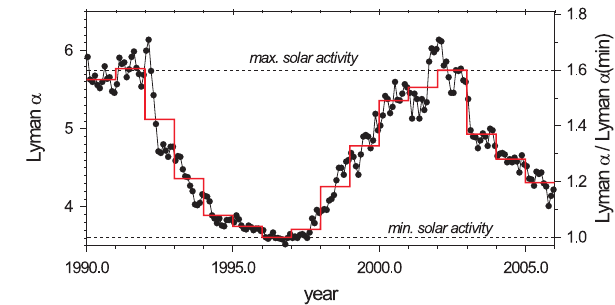
Fig. 2. Variation of the solar Lyman α radiation (units: 10 11 ph.cm − 2 s − 1 ) between 1990–2005 (Woods, 2006). Black dots are monthly mean values, the red curve is based on yearly mean values.